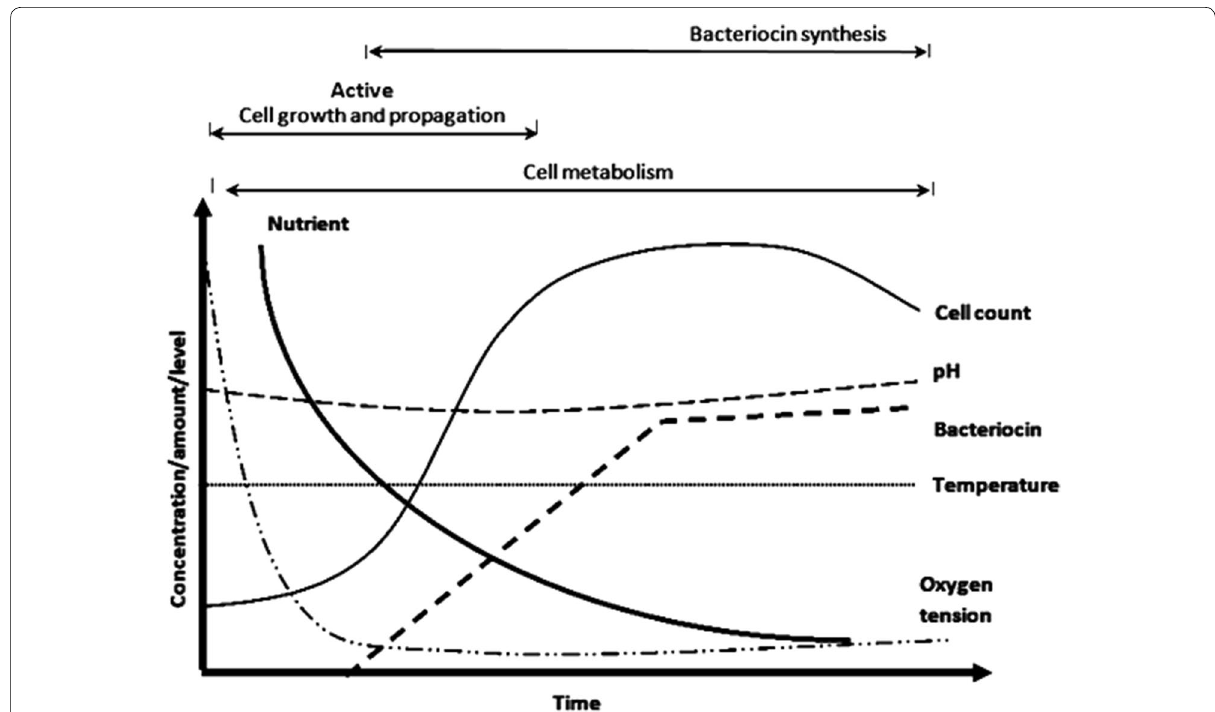
Fig. 2 Typical generalization of fermentation profile of bacteriocins from Bacillaceae based on several research articles and